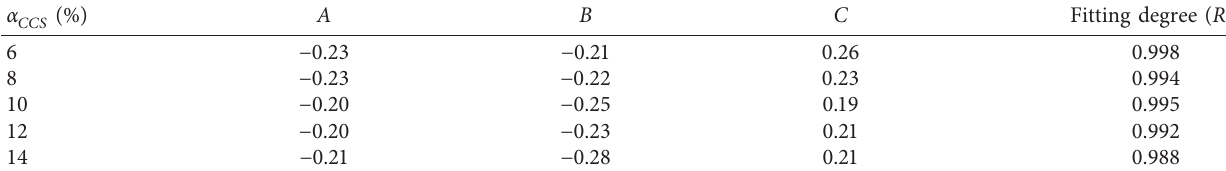
Table 6: Parameters in determining the coefficient of